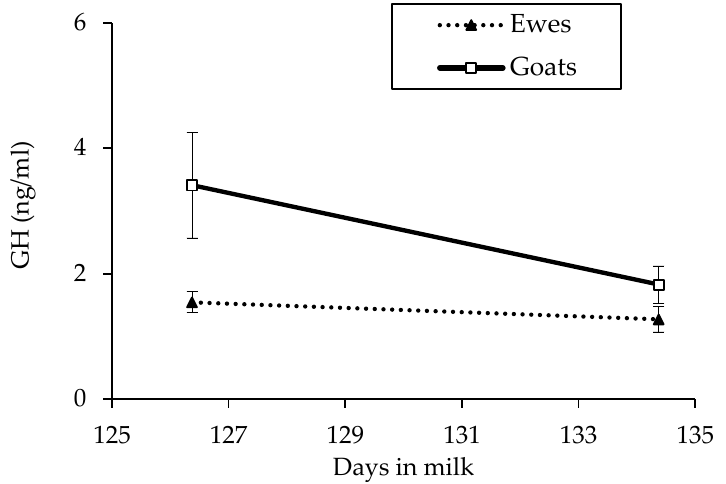
Figure 4. Graphical representation of species × period interaction ( p = 0.04) concerning the growth hormone (GH) concentration detected in plasma of mid-lactating Saanen goats and Sarda ewes. The vertical lines at each symbol indicate the SEM of the values.